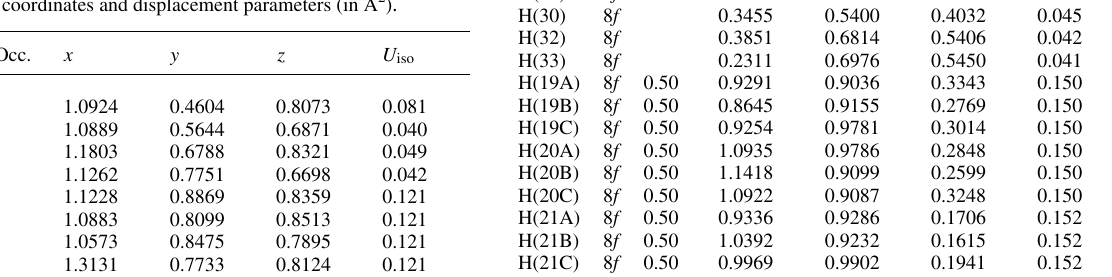
Table 2. Atomic coordinates and displacement parameters (in Å 2 ) .